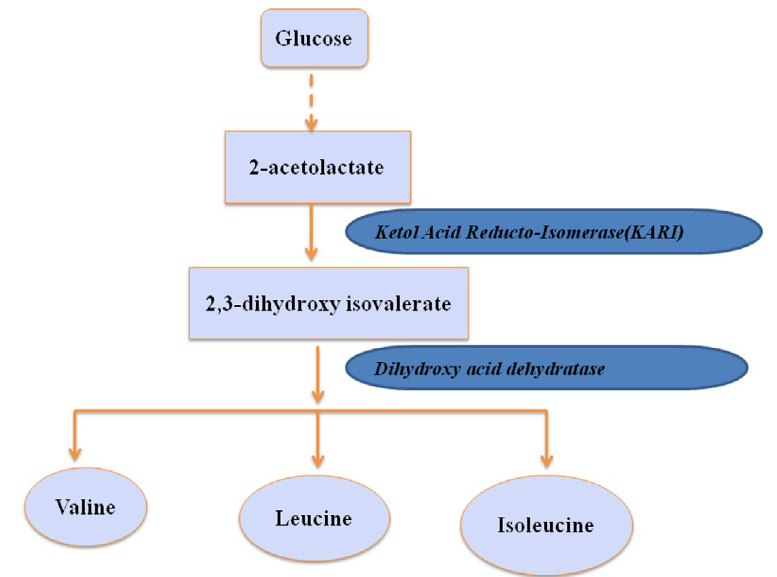
Fig. 2. Biosynthesis of Valine,leucine and Isoleucine.